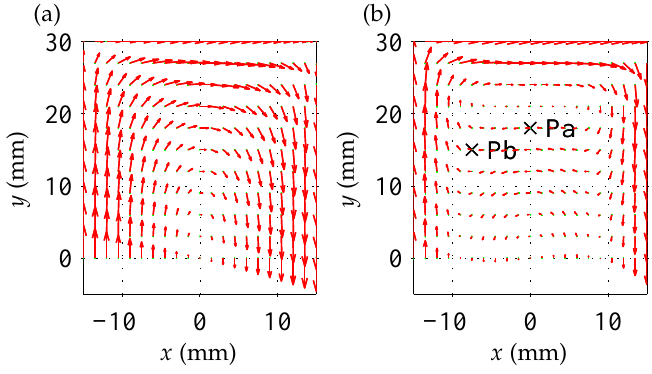
Figure 9. Resulting eddy current distribution using Model B (red contours) and Model C (green contours) evaluated at ω ν t = π /4 with a magnet length l m = 60 mm at two different speeds: ( a ) 1000 rpm; ( b ) 15,000 rpm. Note that the green contours are almost completely covered by the red contours which indicates that the two models predict essentially the same eddy current distribution.